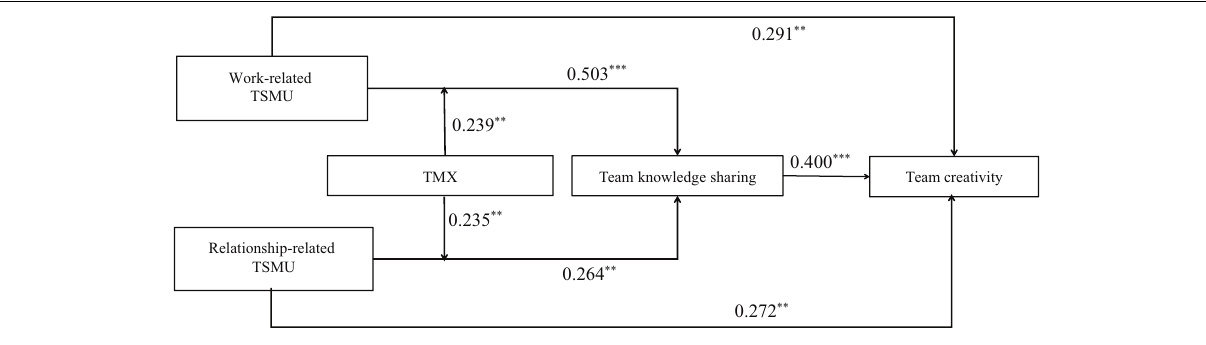
FIGURE 2 | Results of theoretical model by using Mplus. N = 102 teams, ∗∗ p < 0.01, ∗∗∗ p < 0.001. Standardized path coefficients are reported.